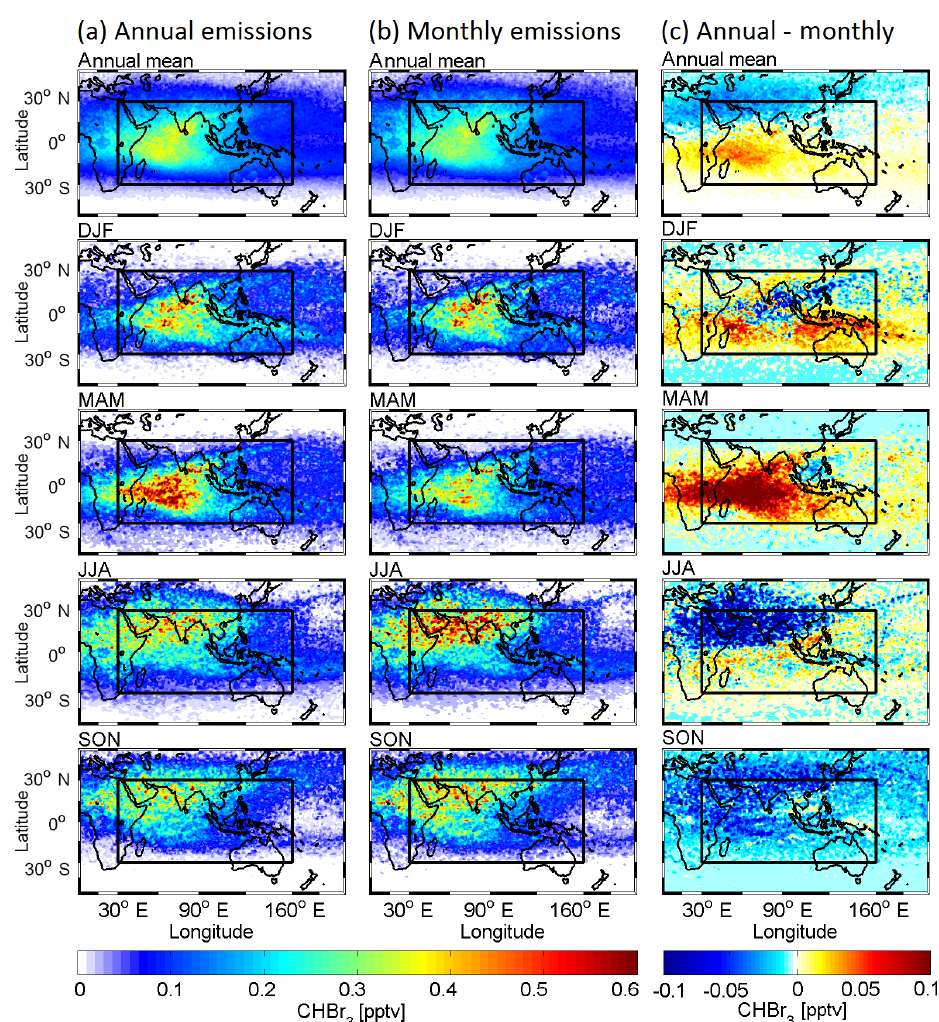
Figure 7. Bromoform volume mixing ratios (VMRs) at 17km for the Ziska Updated (a) annually averaged emissions, (b) monthly averaged emissions, and (c) the difference between the two scenarios. The black box depicts the IO/WP release